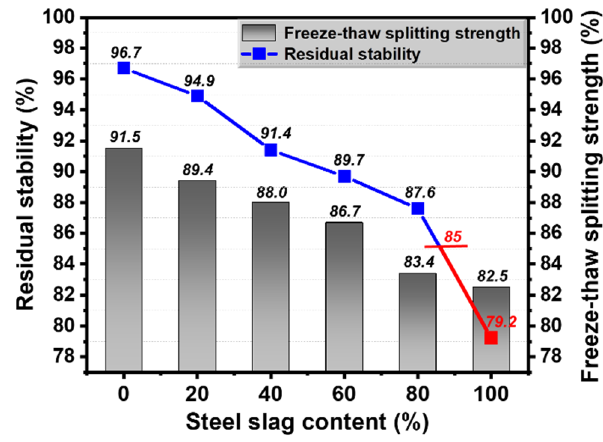
Figure 8. Water stability of different steel slag contents.